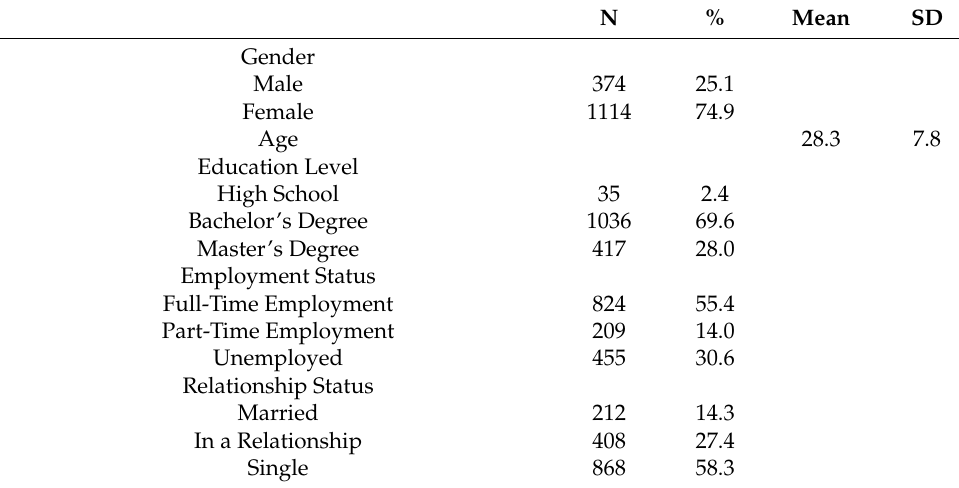
Table 1. Sociodemographics, Self-reported health statuses, and scores on the Problematic Series Watching and mental health